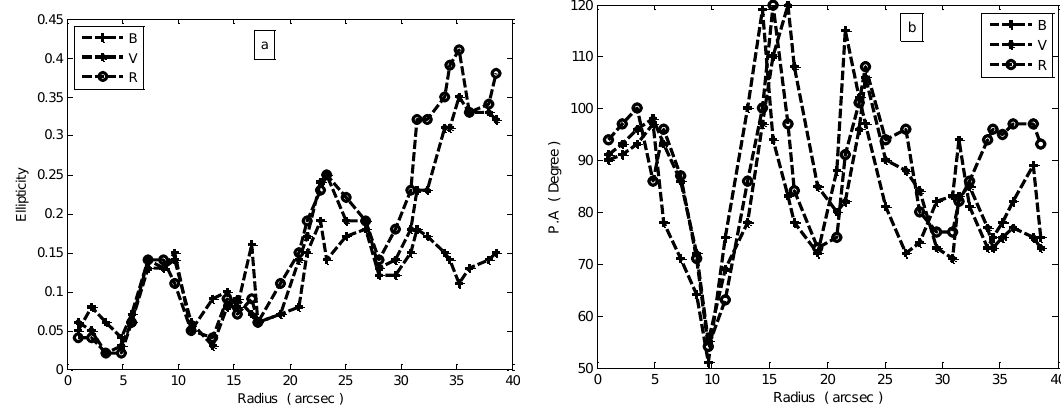
Fig. 4: (a) Isophote ellipticity (b) position angle of the galaxy P. A as a function of the distance r to the center of NGC